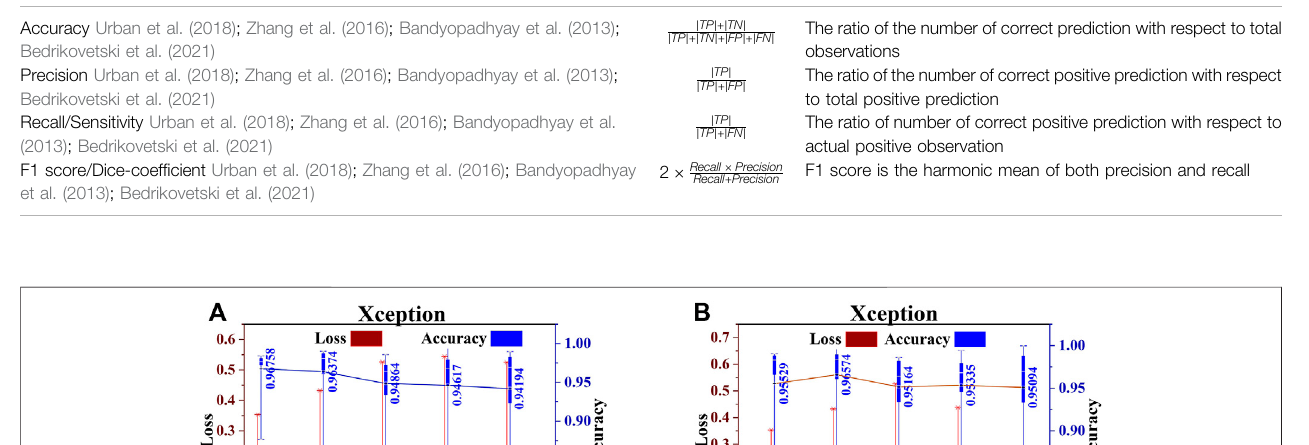
Frontiers in Genetics |